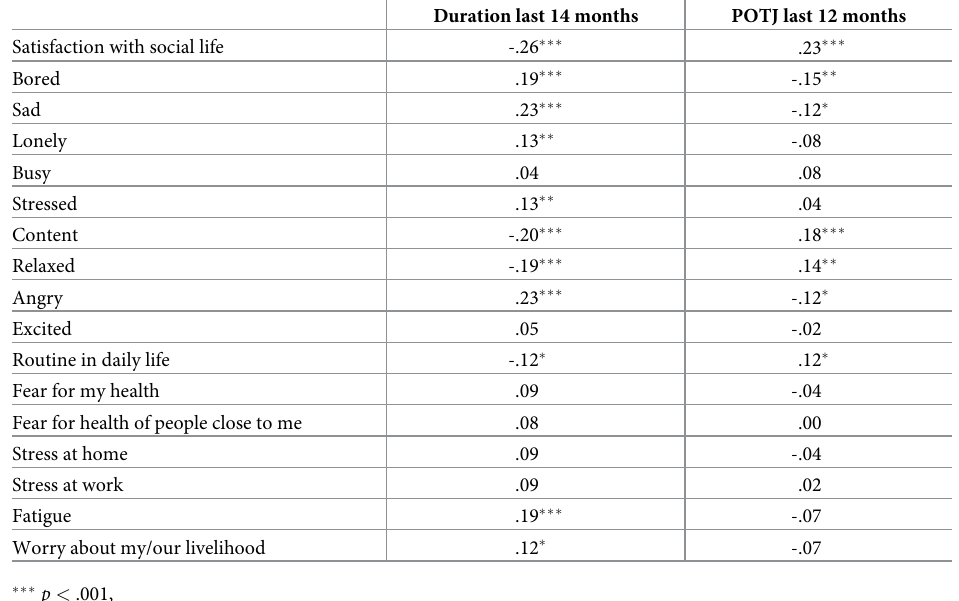
Table 2. Pearson correlation coefficients for the relationships between the subjective durations of the last 14 months, POTJs for the last 12 months, and measures of emotion (9 variables) and routine/stress/worries (7 vari- ables) across all 500